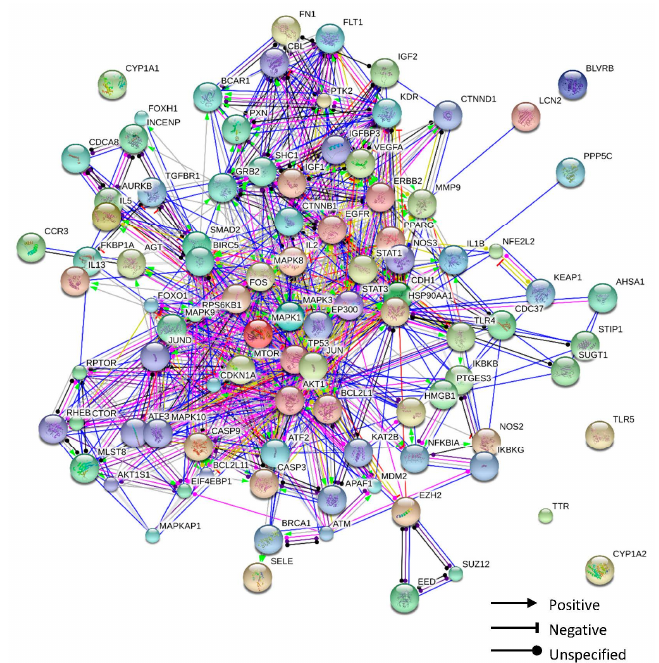
Figure 6. Protein–protein interaction of gastritis-related genes: the shapes of the arrows explain the action effects of interaction of proteins (positive, negative, and unspecified), and the colors of the lines indicate the action types of interaction of proteins. Biomolecules 2020 , 10 , x FOR PEER REVIEW